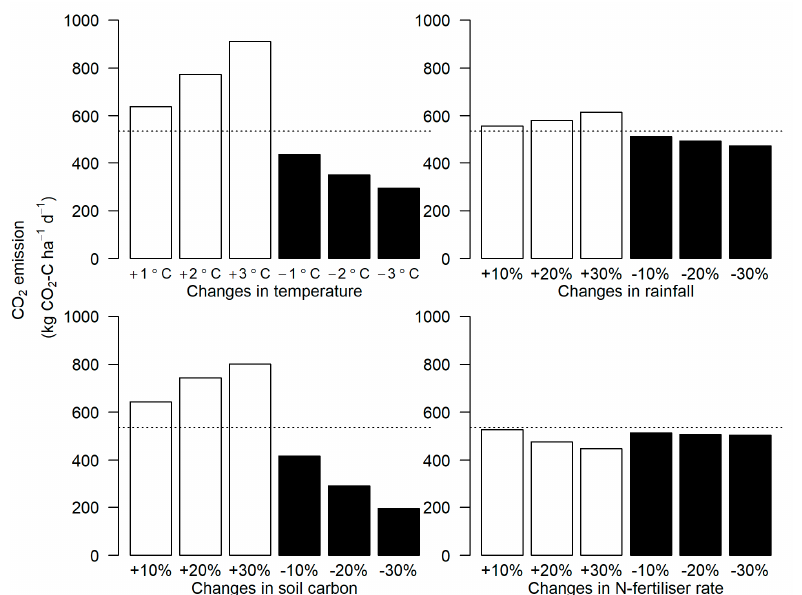
Figure 6. Sensitivity of the DNDC-model due to changes in climate (temperature and rainfall), soil characteristics (soil carbon) and in management practice (nitrogen fertiliser rate) on CO 2 emissions. Dotted line represents the baseline threshold (annual average maximum temperature = 12.8 °C, average daily precipitation = 4 mm, soil carbon = 0.0038 kg C kg − 1 soil and N-fertiliser rate applied = 100 kg N ha − 1 ).